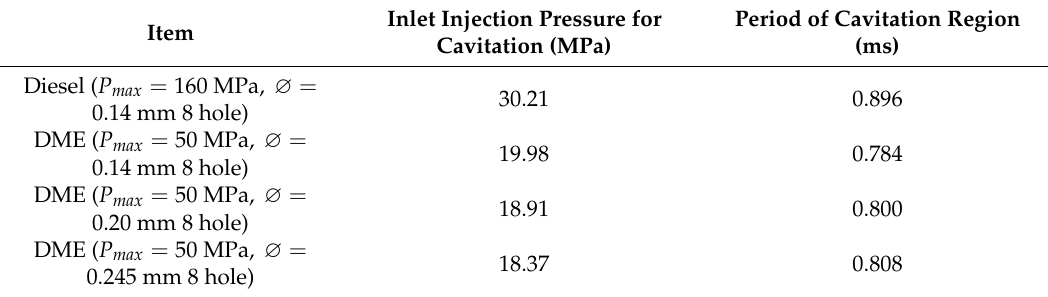
Figure 9. Discharge coefficient during injection.